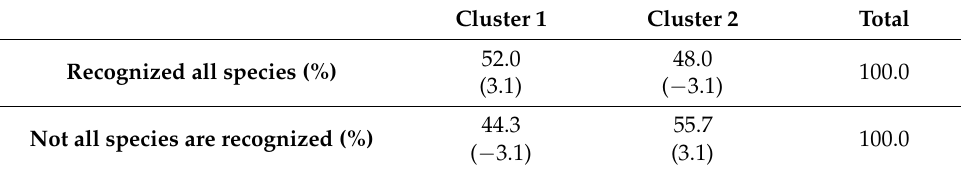
Table 6. The results of the contingency table analysis between clusters and species